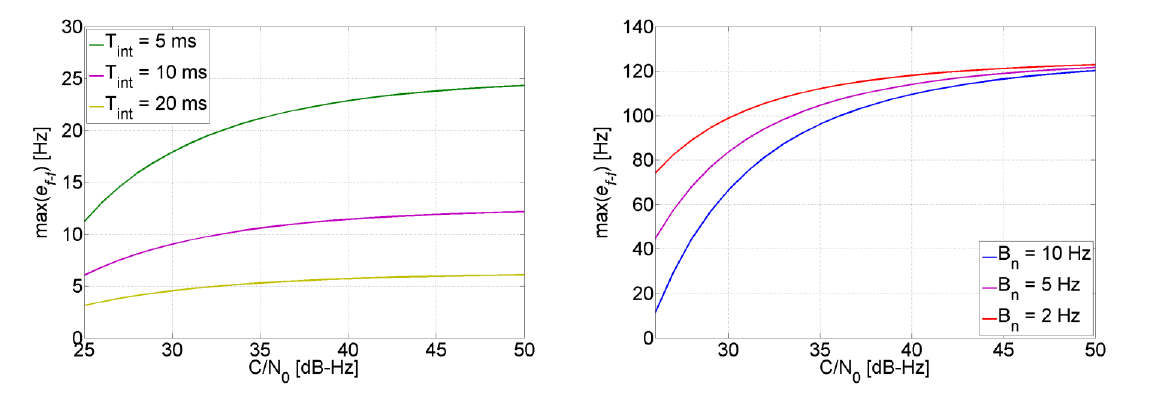
= 1 ms ( left ) and B = 5 Hz ( right int n